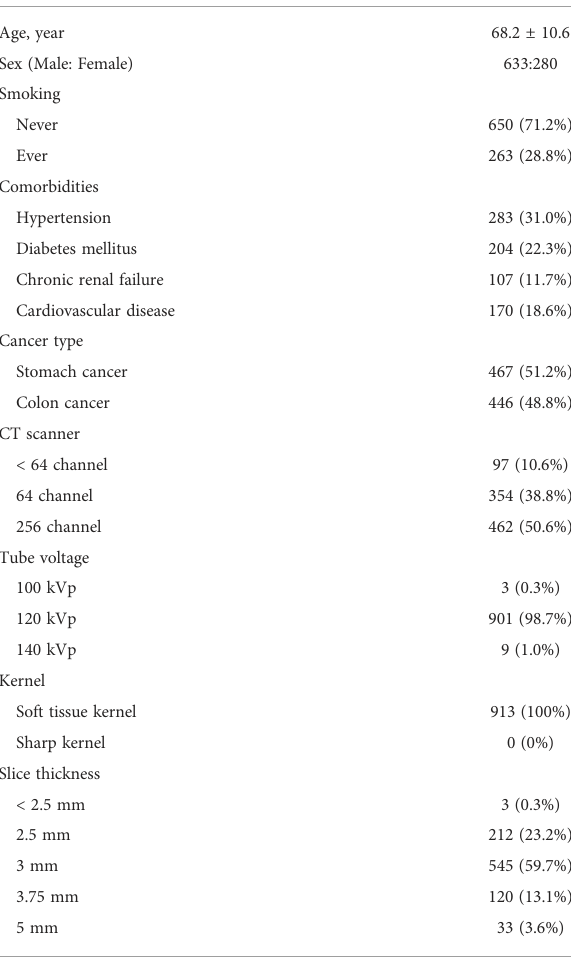
TABLE 1 Baseline patient characteristics and computed tomography acquisition parameters.